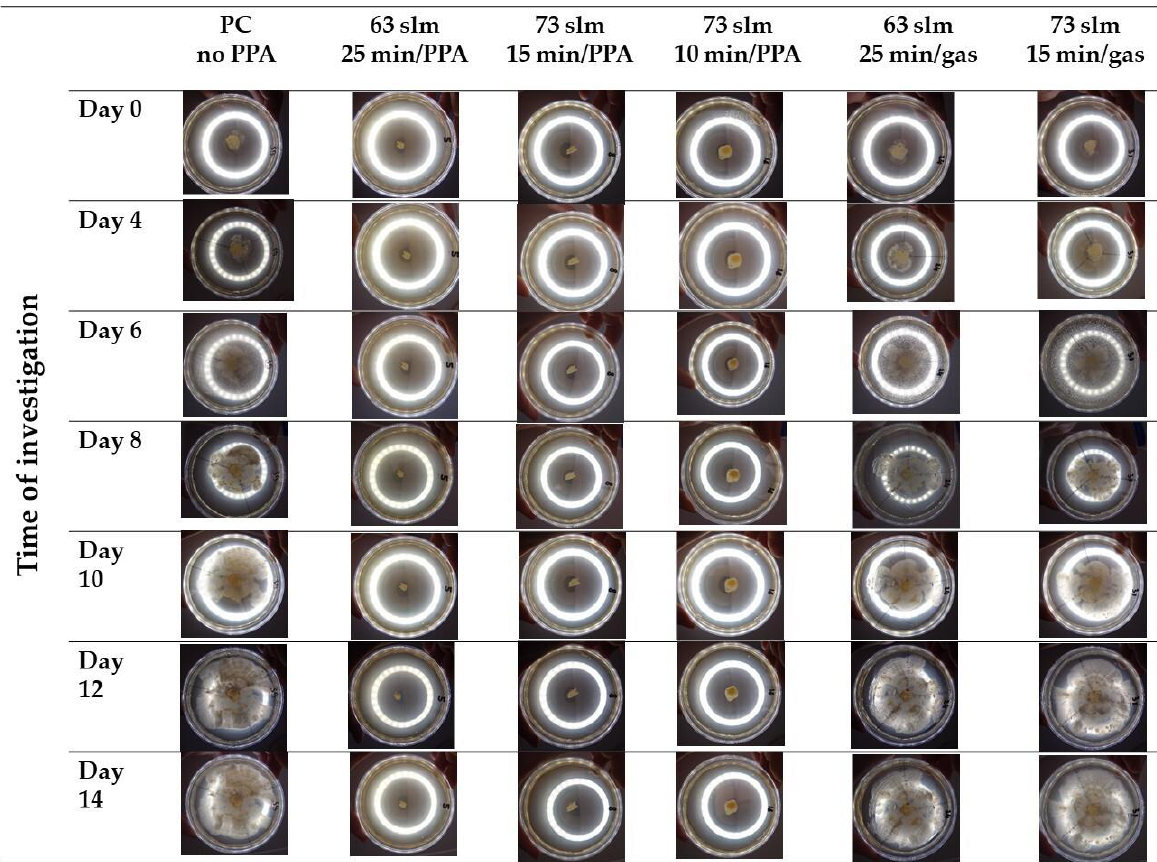
Figure 1. Radial growth of Pythium mycelia on PDA agar plates over 14 days of incubation. One representative replicate of seven replicates per run is displayed. All seven replicates per treatment showed similar results. PC: positive control, inoculated no PPA, two controls using gas flow of air only without microwave torch ignition (i.e., gas) and three different PPA treatment modes. For scaling classification note that petri dishes are 85 mm in